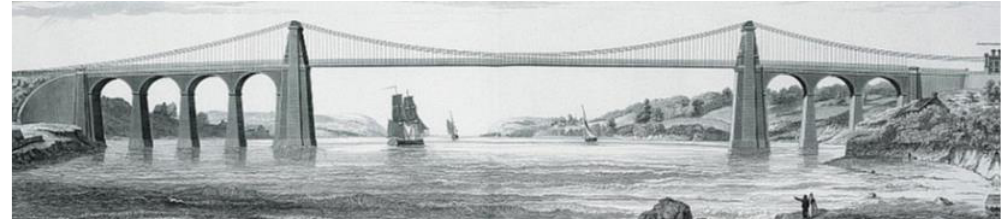
Figure 12. Menai Bridge. General view of the suspended structure designed by Telford, Wales. 1826. Source: “Scottish Engineering Hall of Fame”. engineeringhalloffame.org. August 2015.